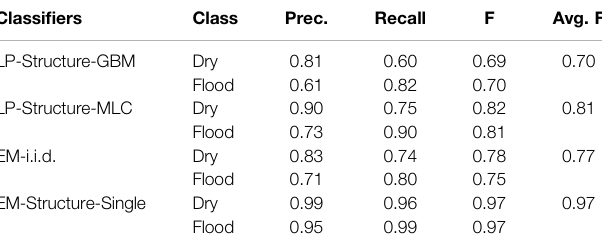
TABLE 4 | Comparison on Mathew, Grimesland fl ood